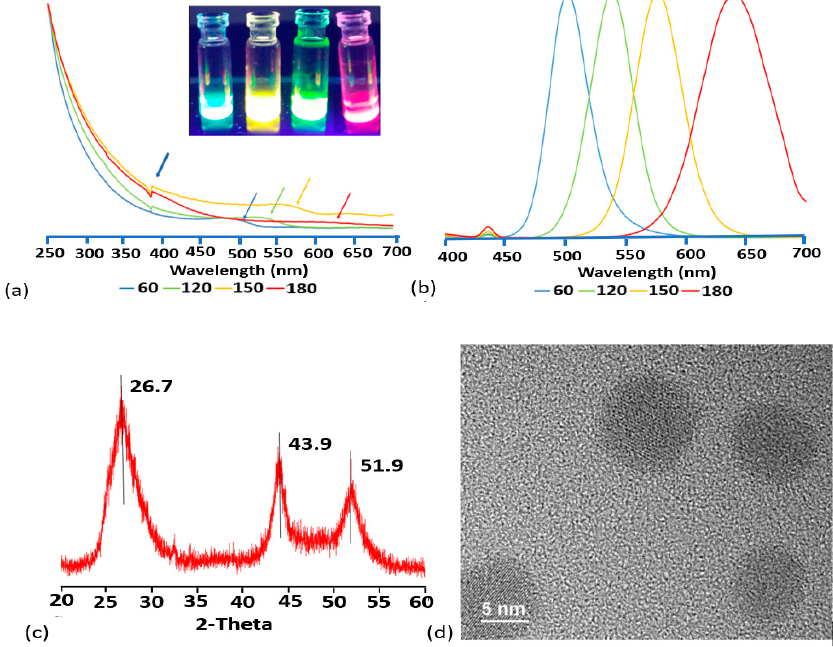
Figure 1. UV-Vis spectra ( a ), photoluminescence ( b ), XRD ( c ), and HR-TEM ( d ) analysis of CdSTe QDs. Sky-blue, yellow, green, and red arrows ( a ) denote the bandgap energy of each QD.